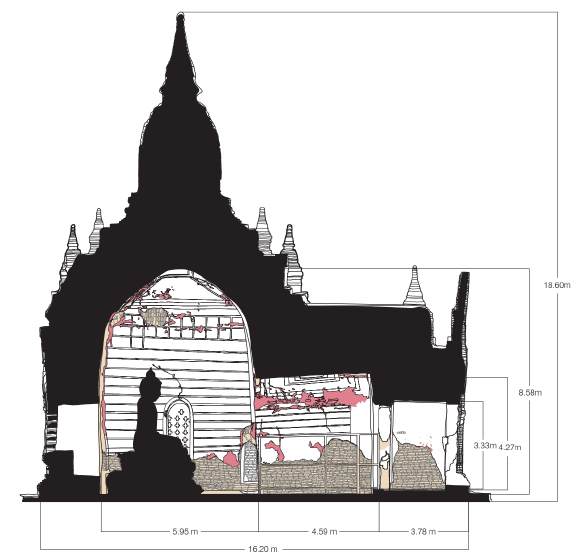
Figure 7. BIM of Loka Hteik Pan (Mezzino et al.,